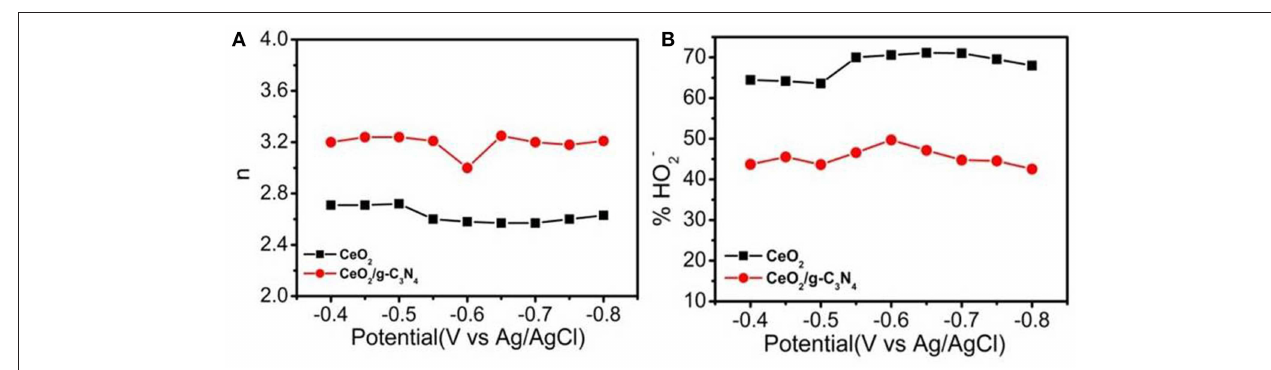
FIGURE 7 | (A) Electron transfer number, (B) % of HO − 2 formation of CeO 2 and CeO 2 /g-C 3 N 4 .